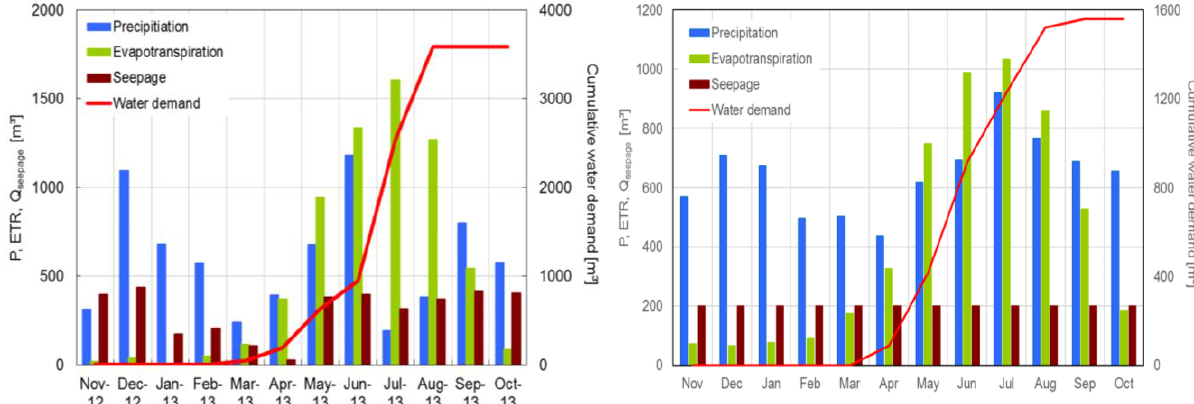
Figure 9. Long-term mean monthly precipitation, evapotranspiration, seepage, and cumulative water demand (m³ ha -1 ) for the Sphagnum farming site, calculated using precipitation data from Bremen meteorological station (1993–2013, German Meteorological Service DWD).